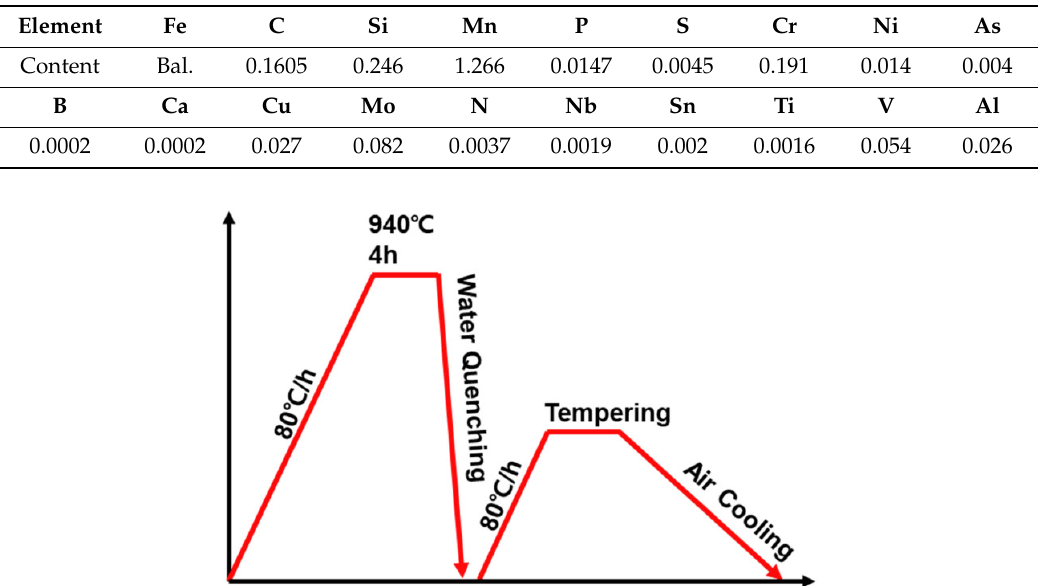
Table 1. Chemical composition (mass %) of the present steel sheet.